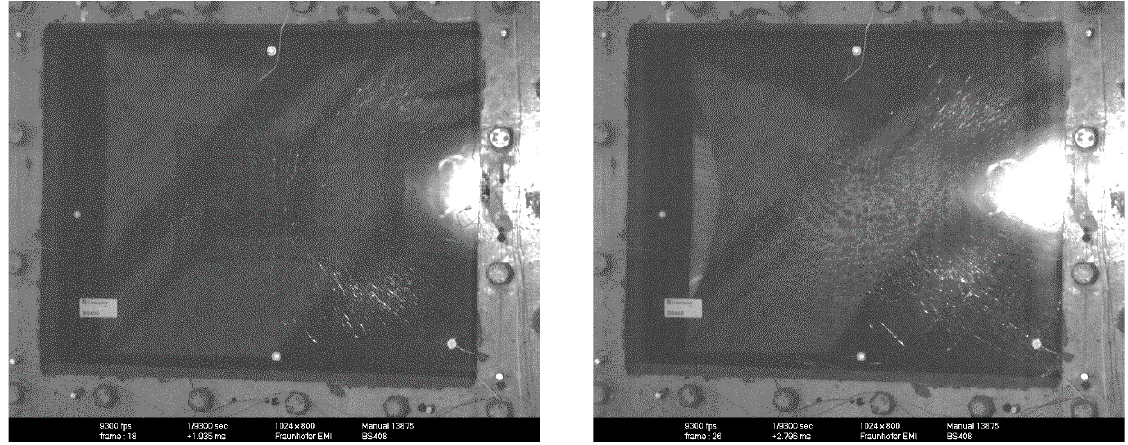
Fig. 5 Crack development during BS 408 test: cracks reach sensors at t = 1.935 ms (left); crack pattern approx. 1 ms after breakage at t = 2.796 ms (right).